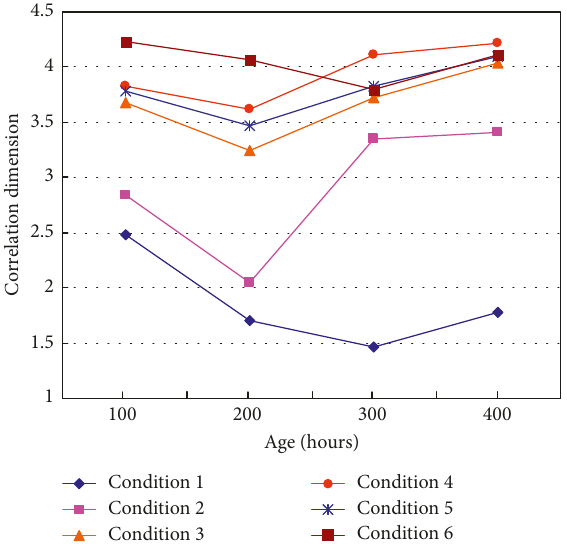
Figure 21: Diagram of dimensions, age, and working conditions.